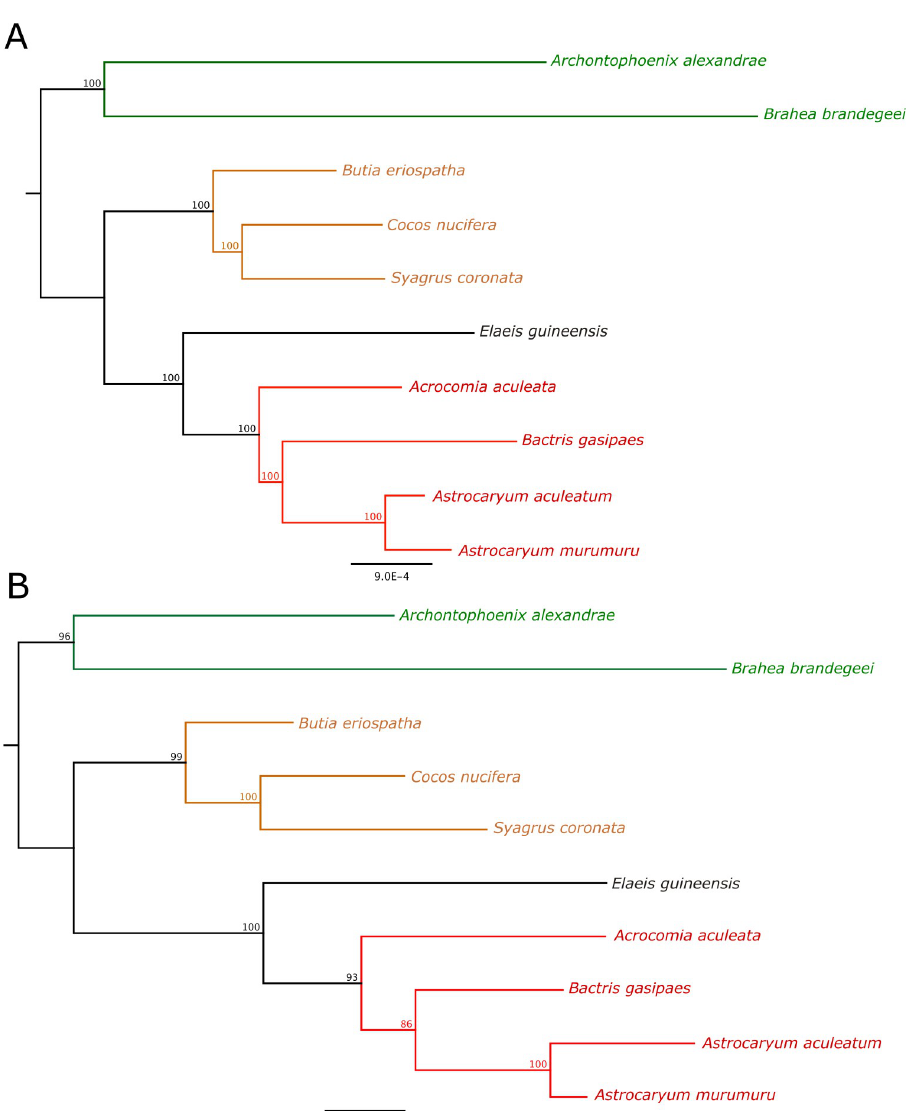
Fig 4. Phylogenetic trees based on maximum likelihood inference. A –Phylogenetic inference using plastome sequences (one IR removed); B— Phylogenetic inference using the ten plastome regions with greatest sequence variability (SV%) values. The numbers above the branches are maximum likelihood bootstrap values (1000 replicates).